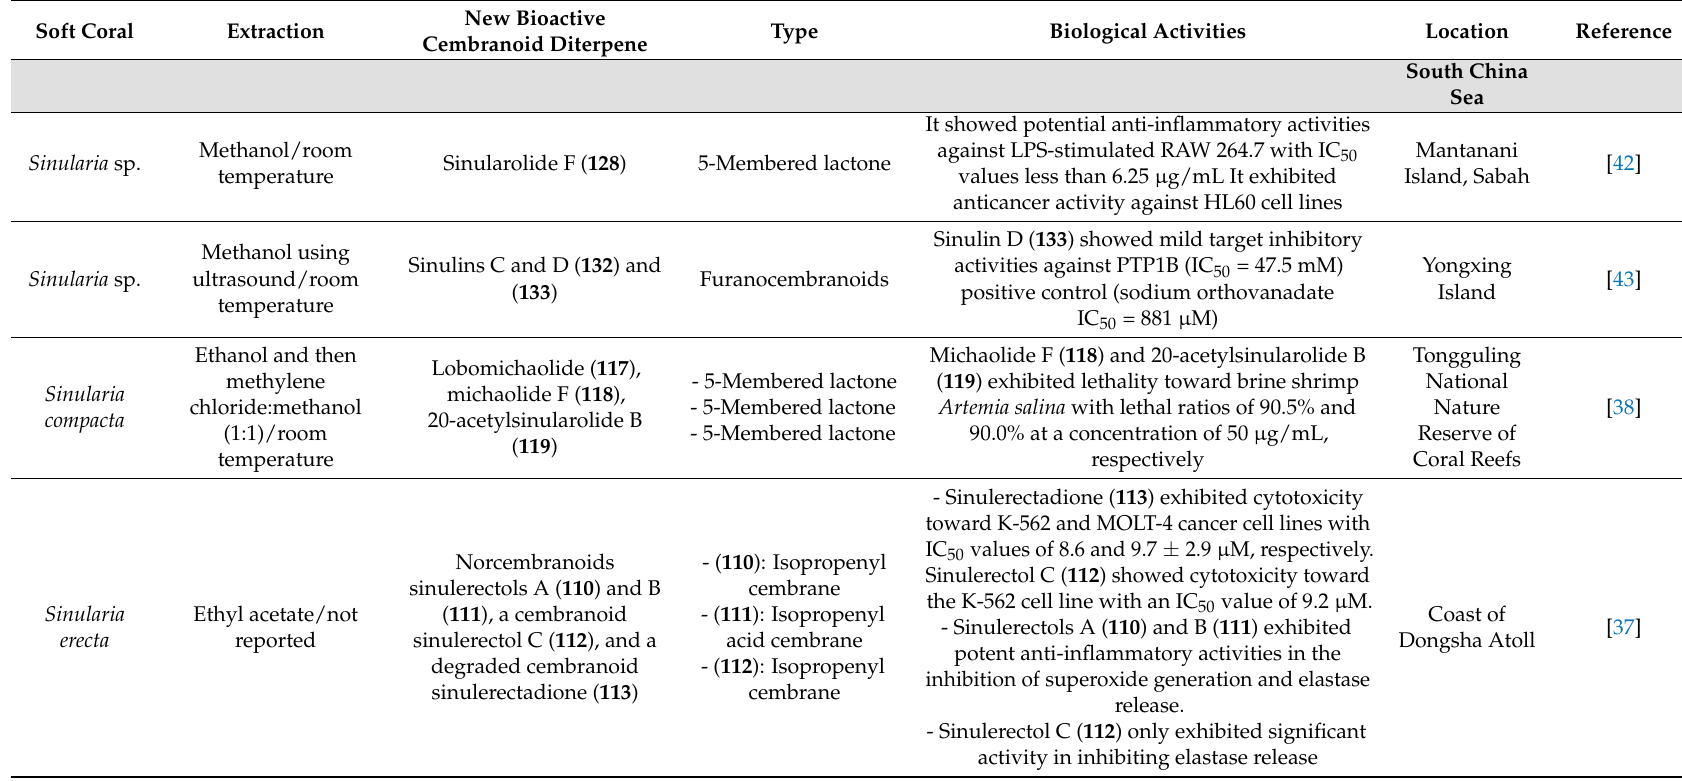
Table 3. Harvesting locations of the soft corals of the genus Sinularia , extraction solvent, new compounds identified and their biological properties. Soft